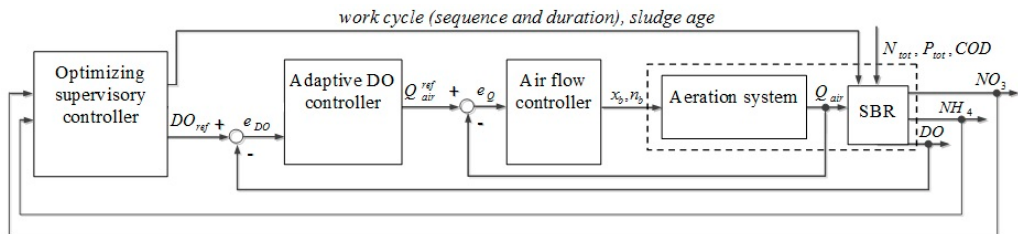
Figure 3. Structure of the hierarchical control system: Q air , n b , x b , e DO , e Q , N tot , P tot , COD, NO 3 , NH 4 are the air flow [m 3 /h], blower speed [rpm], state of blower: on/off [-], error of DO [g O 2 /m 3 ], error of air flow [m 3 /h], total nitrogen [g N/m 3 ], total phosphorus [g P/m 3 ], chemical oxygen demand [g O 2 /m 3 ], nitrate concentration [g N/m 3 ], ammonia concentration [g N/m 3 ], respectively. The abbreviation for reference trajectory is designated as ref .